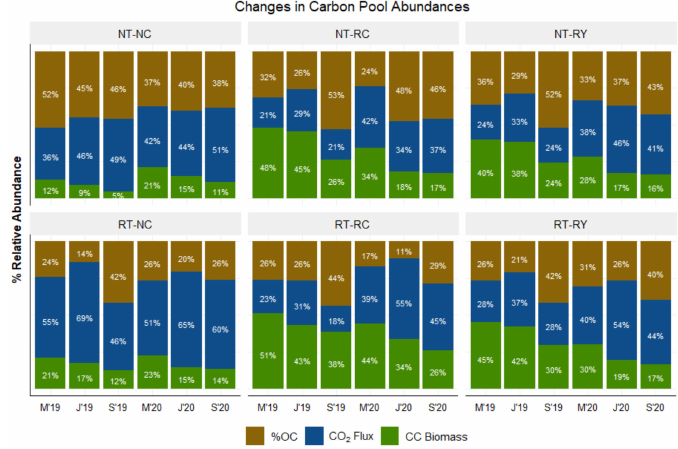
Figure 8. Changes in Carbon Pool Abundances. Figure 8 depicts changes in relative abundances (percentages shown) of each carbon (C) pool (percent organic carbon (%OC), carbon dioxide (CO 2 ) Flux and cover crop (CC) biomass) within each treatment combination (NT = no-till, RT = reduced till, NC = no cover, RC = rye + clover cover crop, RY = rye cover crop) at each month (M = May, J = July, S = September) in the study years (19 = 2019, 20 = 2020). Treatment plots were located in Stoneville, MS, USA. Table 3. Predicted %OC:CO 2 within Treatments. Tillage Cover